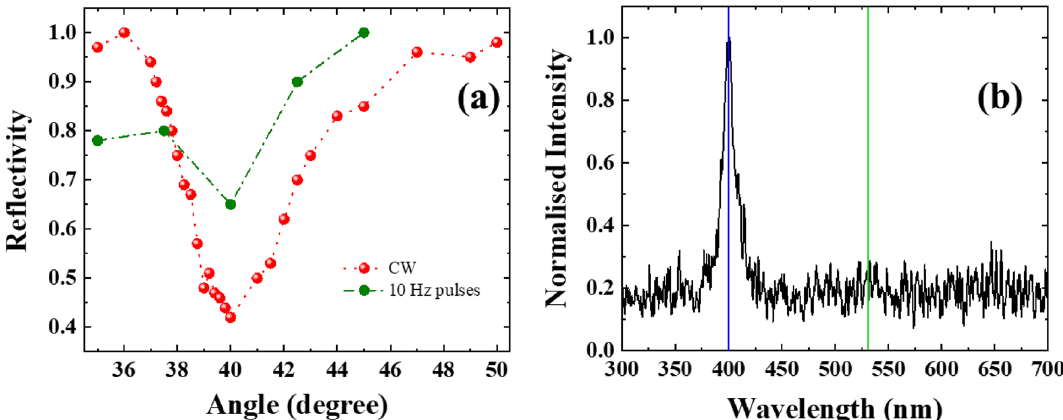
Figure 2. ( a ) Reflectivity of Gr500 as a function of angle of incidence. ( b ) The plasma emission for Gr500 shows generation of 2 ω (400 nm) and the absence of 3/2 ω (532 nm). The blue line indicates the position of 400 nm whereas green line indicates the position of 532